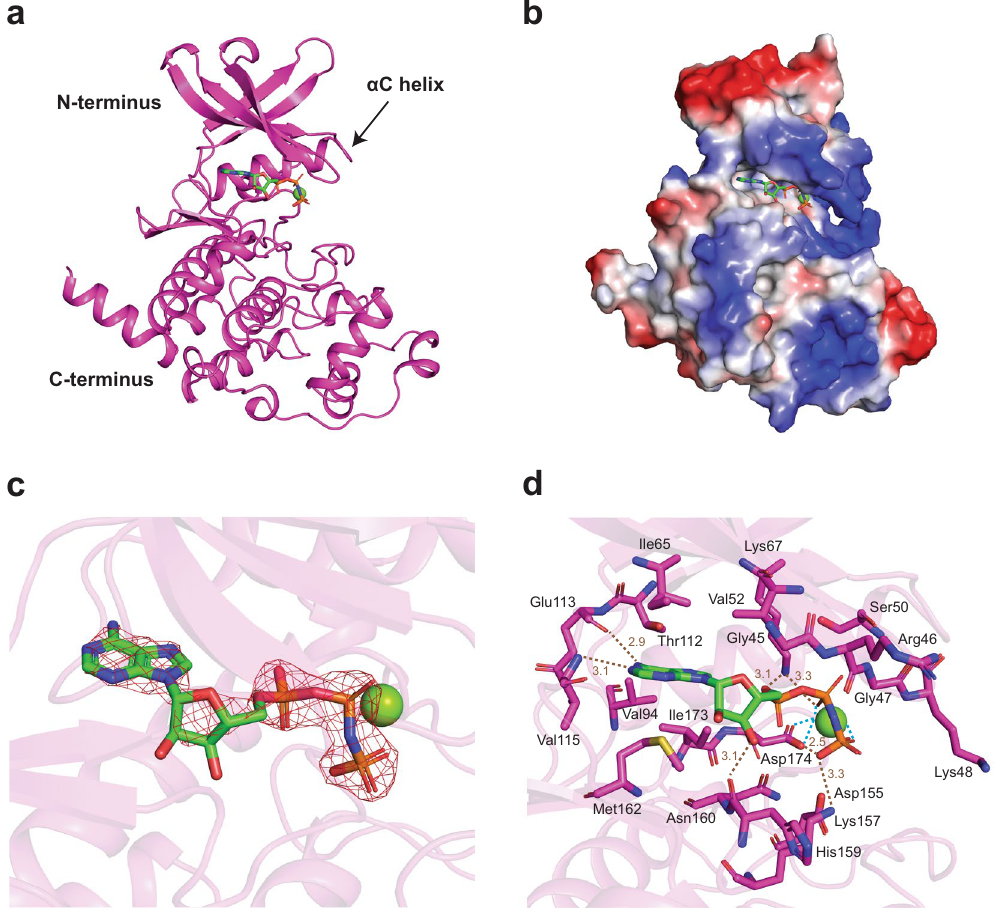
Figure 1. Overall structure of cn Cka1-AMPPNP-Mg 2 + . cn Cka1 is shown in magenta and AMPPNP in green. The coordinating Mg 2 + ion is shown as a green sphere. ( a ) Structure of cn Cka1-AMPPNP-Mg 2 + consisting of an ATP-binding site, N-terminal β -sheets, a critical α C helix as well as C-terminal α -helices. ( b ) Electrostatic potential map depicting the hydrophobic ATP-binding cleft where AMPPNP-Mg 2 + lies. Basic regions are shown in blue, acidic regions in red and hydrophobic regions in white. ( c ) 2Fo-Fc map showing the binding of AMPPNP-Mg 2 + at the ATP-binding site contoured at 2.0 σ . ( d ) Interaction between cn Cka1 residues and AMPPNP-Mg 2 + . Hydrogen bonds are depicted as brown dashed lines. Blue dashed lines depict the coordination of the Mg 2 + ion by the β - and γ -phosphates of AMPPNP and